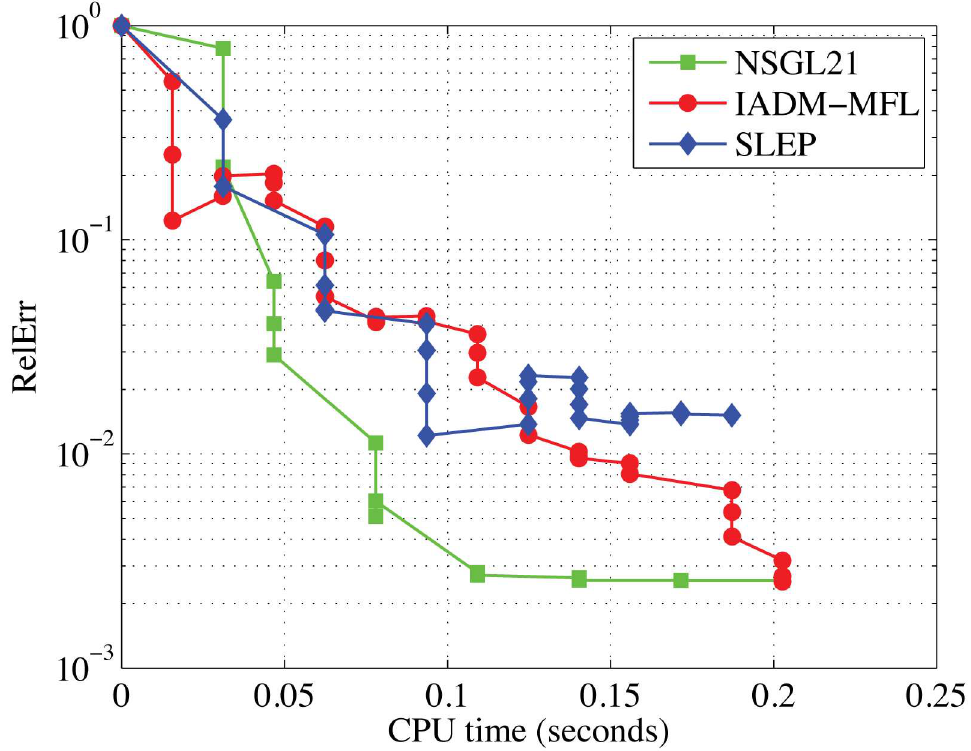
Fig 2. Comparison results of NSGL21, IADM MFL, and SLEP. The x-axes representsthe CPU time in seconds and the y-axes represents the relative error.